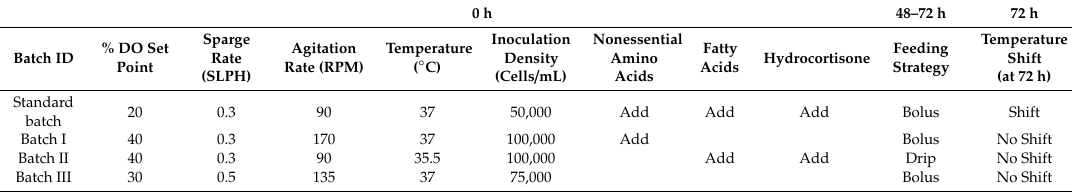
Table 1. Operating patterns of the batches used in this study.